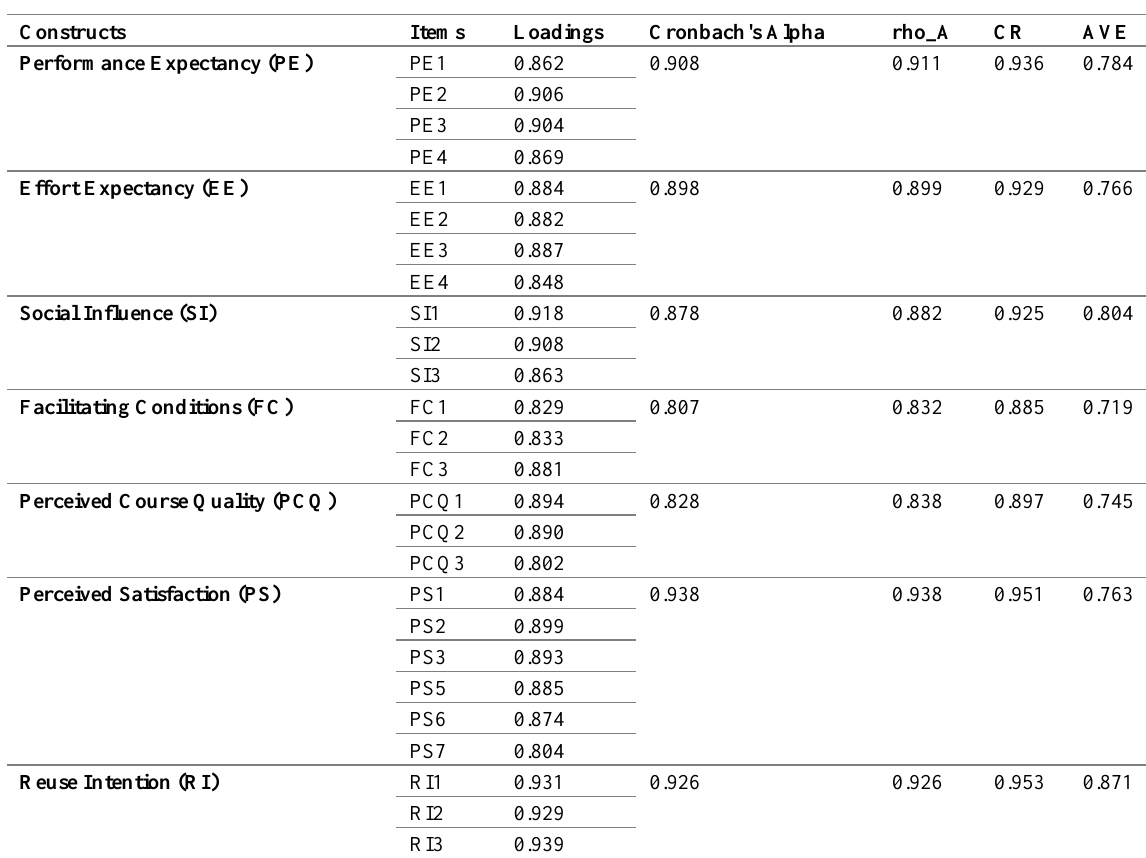
Table 2: Construct Internal Consistency Reliability and Validity